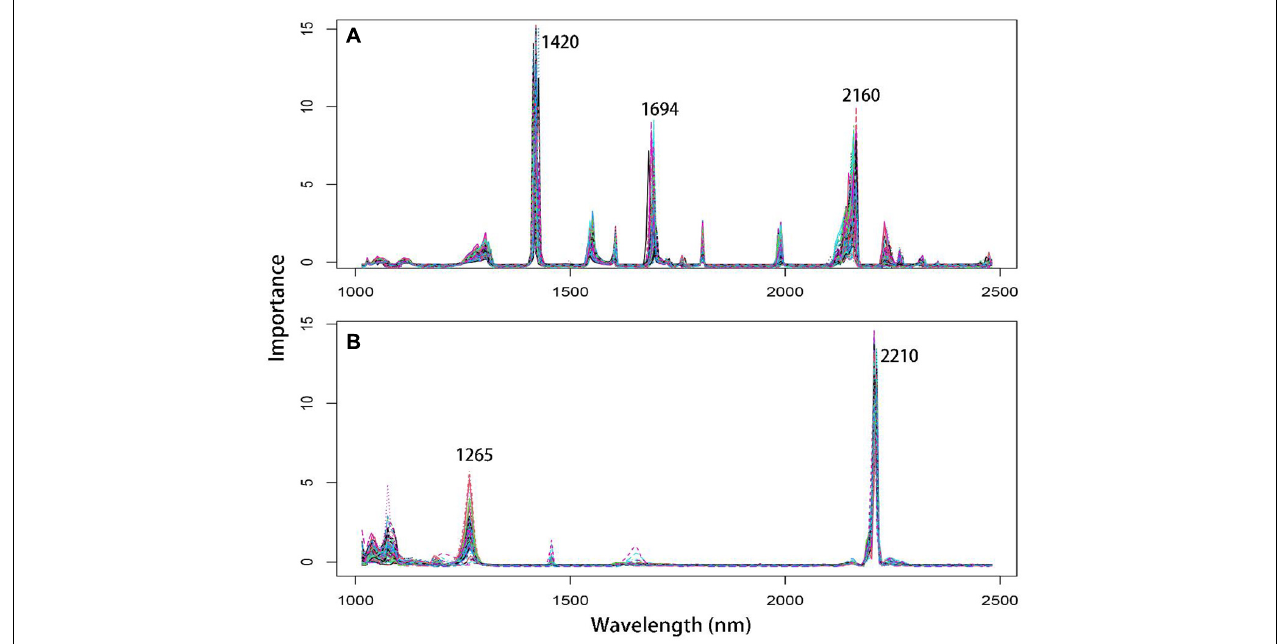
FIGURE 2 | Characteristic wavelength extraction map of T. sinensis seedling leaves based on optimal spectral preprocessing and variable selection methods. (A) Chlorophyll content characteristic wavelength selection with the Ga variable selection method. (B) Nitrogen content characteristic wavelength selection with the sMC variable selection